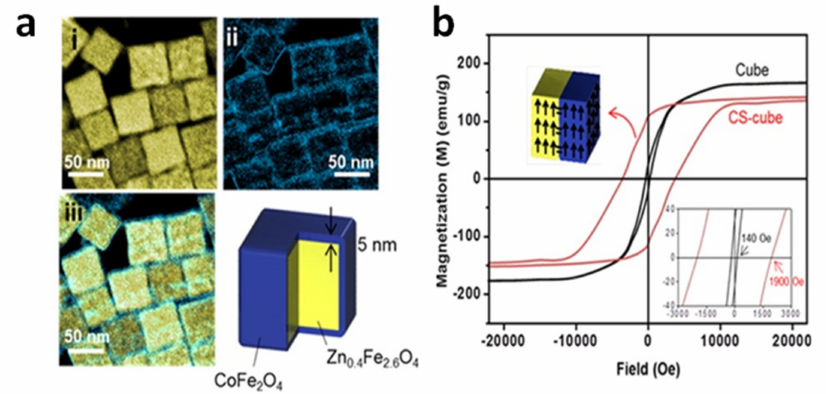
Figure 2. ( a ) Electron energy loss spectroscopy (EELS) mapped images of cubic CS_NPs with Zn 0.4 Fe 2.6 O 4 core and CoFe 2 O 4 shell. (i) Yellow and (ii) blue regions represent Fe and Co, respectively, and (iii) the merged image. ( b ) Magnetic hysteresis loops measured at T = 300 K on the CS_NPs and Zn 0.4 Fe 2.6 O 4 cubic NPs with similar size (~60 nm). The coercivity of the CS_NPs was ~1900 Oe, 14 times larger than that of the single-phase cubes (~140 Oe). Adapted with permission from Ref. [119], Copyright 2012 American Chemical Society.